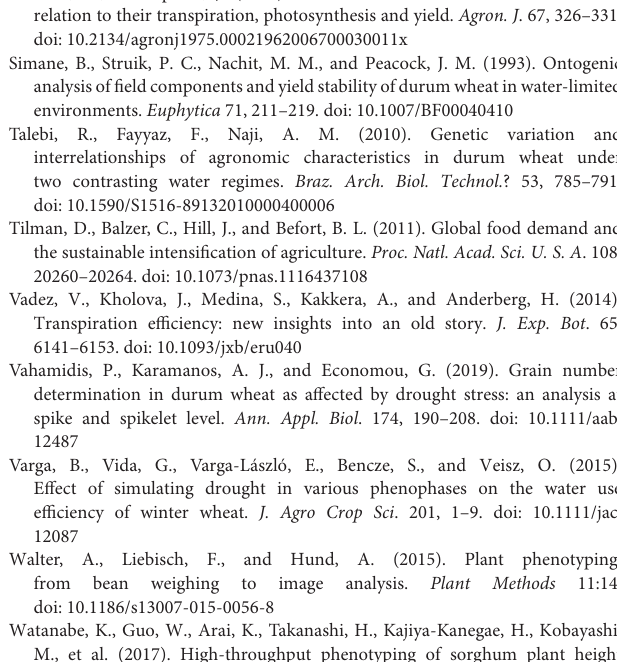
Tabrizi, N., and Poczai, P. (2020). Effects of drought stress on some agronomic and morpho-physiological traits in durum wheat genotypes. Sustainability 12:5610. doi: 10.3390/su12145610 Priestley, C. H. B., and Taylor, R. J. (1972). On the assessment of surface heat flux and evaporation using large-scale parameters. Monthly Weather Rev . 100, 81–92. doi: 10.1175/1520-0493(1972)100 < 0081:OTAOSH >